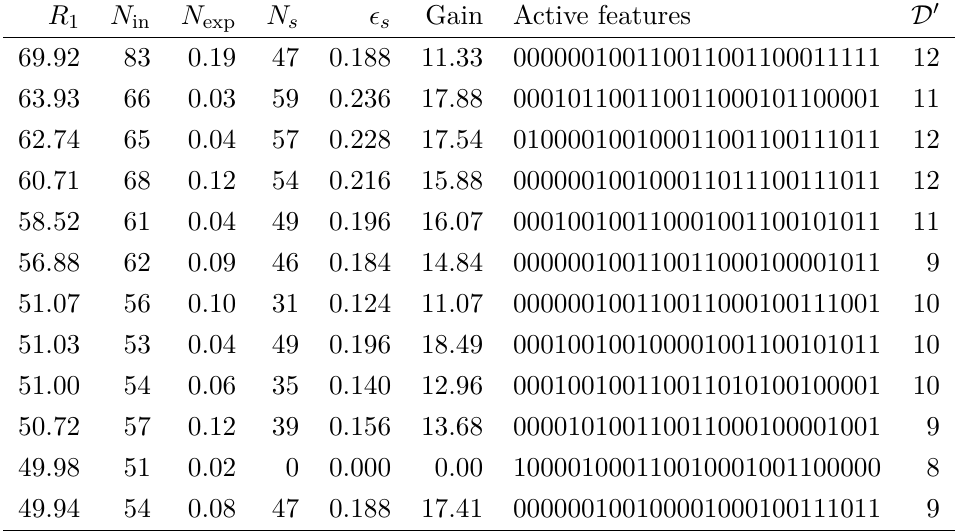
Table 4 . Results of an exploratory RanBoxIter search on the HEPMASS dataset with a 5% signal contamination. The 12 most significant boxes are reported, such that we may include a negative result (the 11 th most significant box). D 0 is the dimensionality of the reported box. For other detail see the